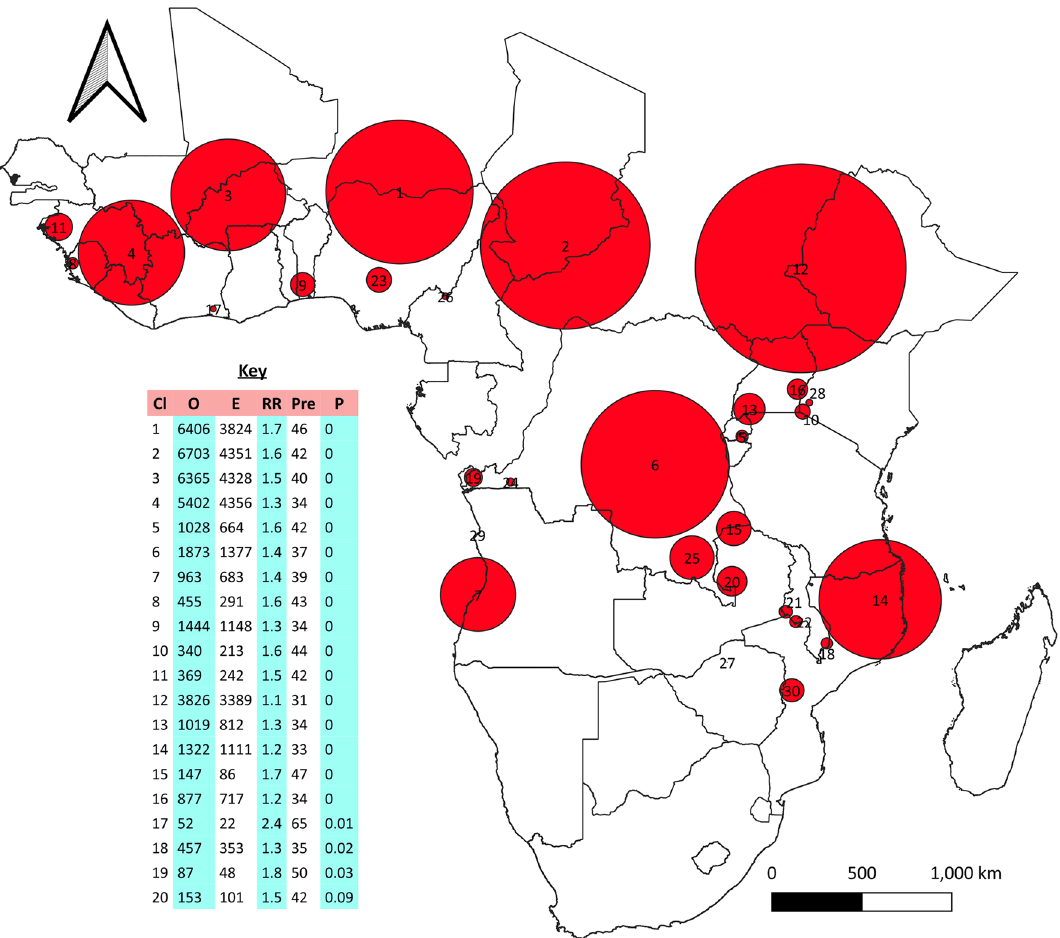
Figure 6. High-value clusters: the red circular shape shows the windows of the hotspots of mothers who have experienced at least one child’s death. Cl cluster number on the map, O observed cases in the clusters, E expected cases in the cluster, RR relative risk, Pre prevalence, P P value. To conduct this analysis was used SaTScan v9.6 and QGIS.